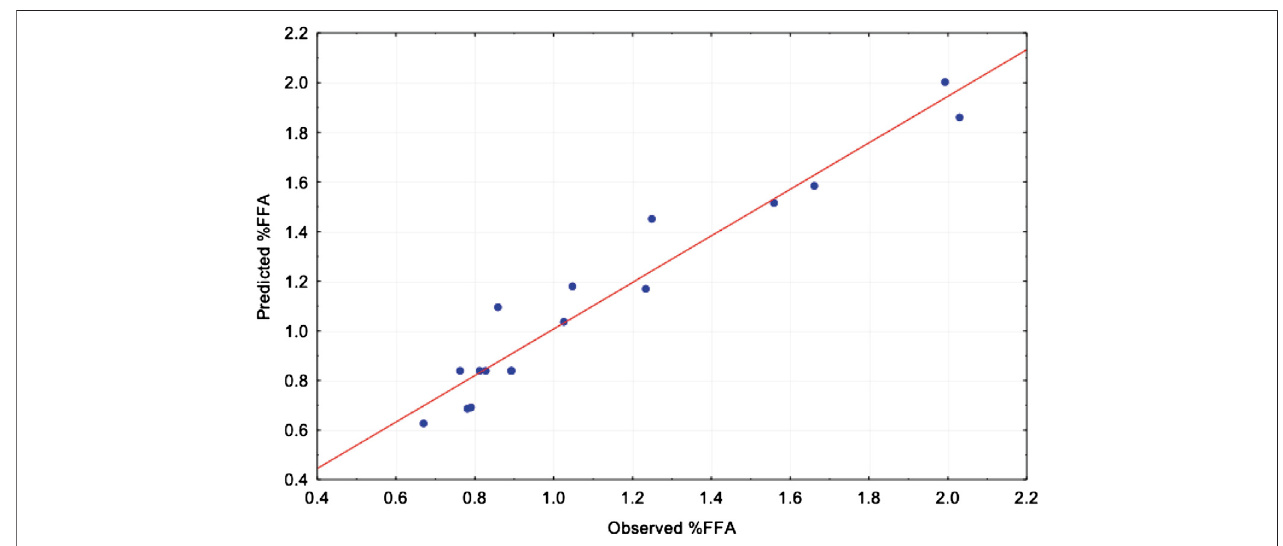
FIGURE 3 | Parity plot for the actual and predicted values of % FFA for RSM model.